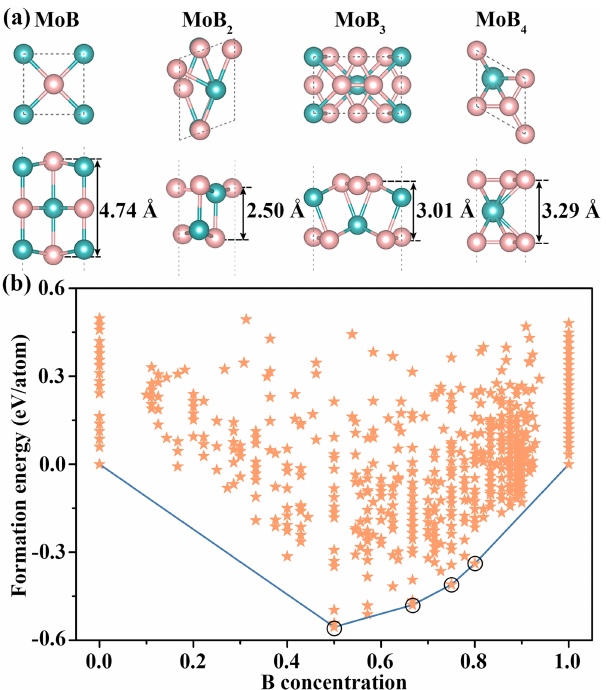
Fig. 1 Structure. a Top and side views of the MoB x ( x = 1, 2, 3, and 4) monolayers (pink balls = B atoms, blue balls = Mo atoms). b Formation energy per atom of MoB x as a function of the B concentration x /( x + 1). The black circles mark the MoB x ( x = 1, 2, 3, and 4) monolayers.